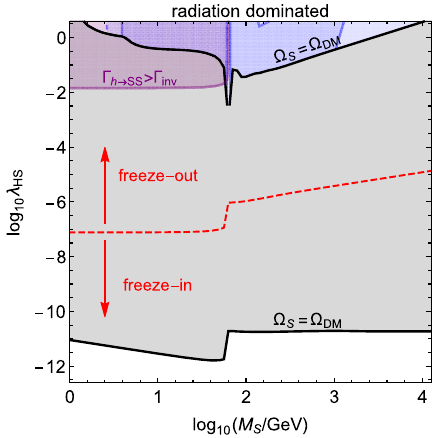
Fig. 3 The red dashed line shows the thermalization bound for λ HS . The colored regions are the same as in Fig. 2, and the upper and lower solid black lines show the values of λ HS which give the observed DM abundance via freeze-out and freeze-in,